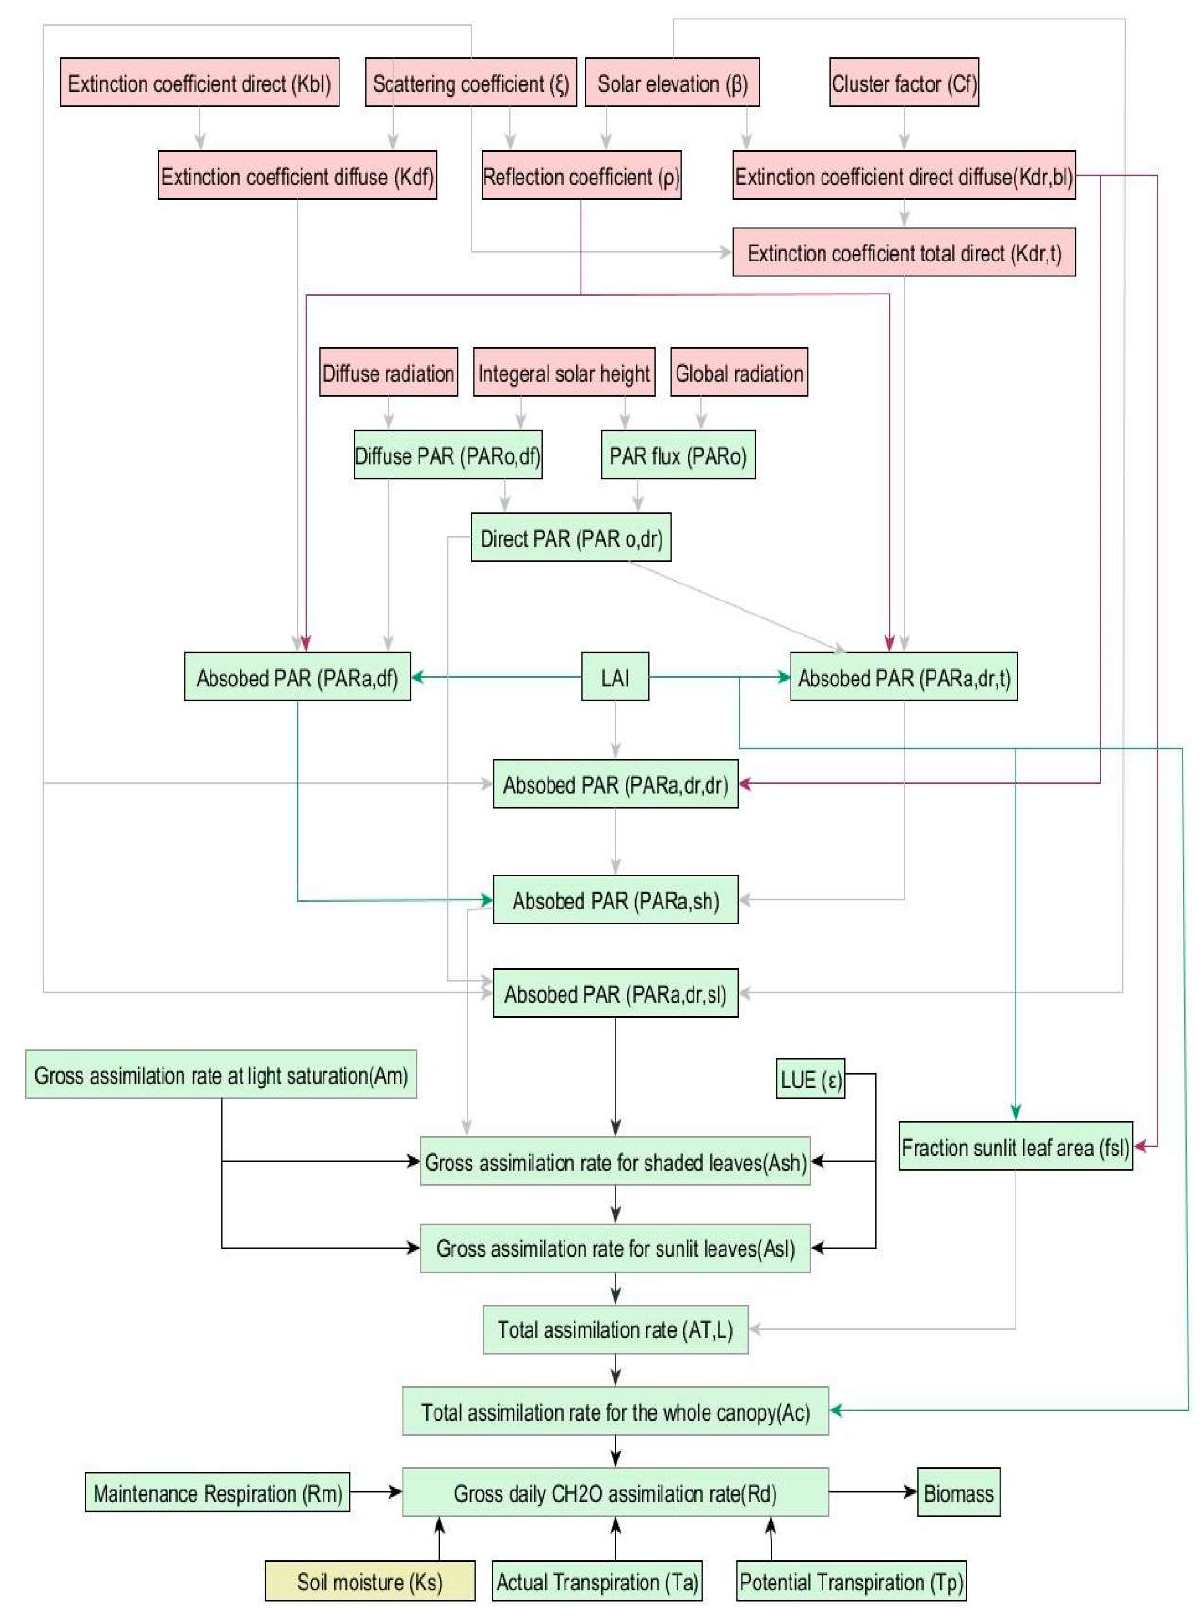
Figure A2. Flowchart of the WOFOST model. (Source: [5] ).